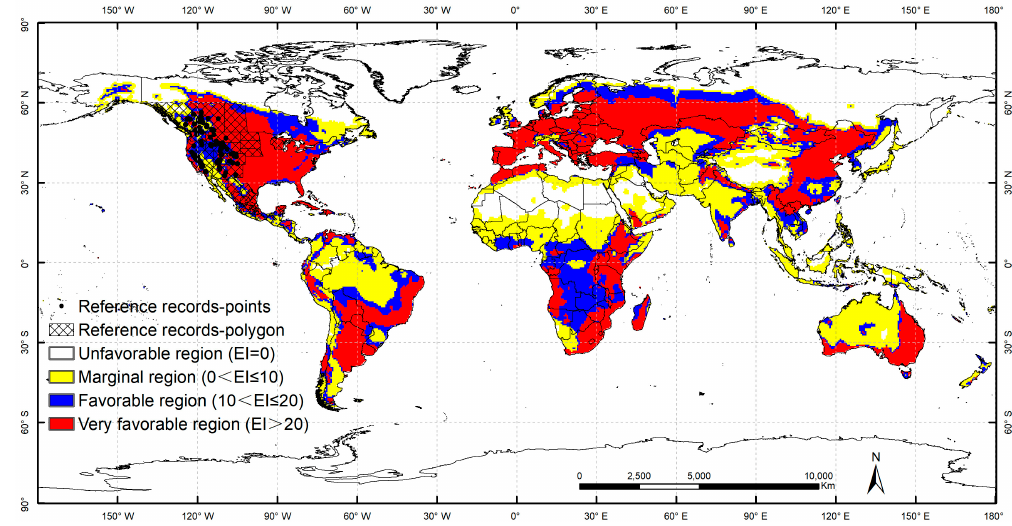
Figure 3. Predicted potential global distribution under historical climate conditions and the known global occurrence records of D. ponderosae . The unfavorable, marginal, favorable, and very favorable regions were painted in white, yellow, blue, and red, respectively. The known distribution based on published records were filled with black dots and mesh polygons.